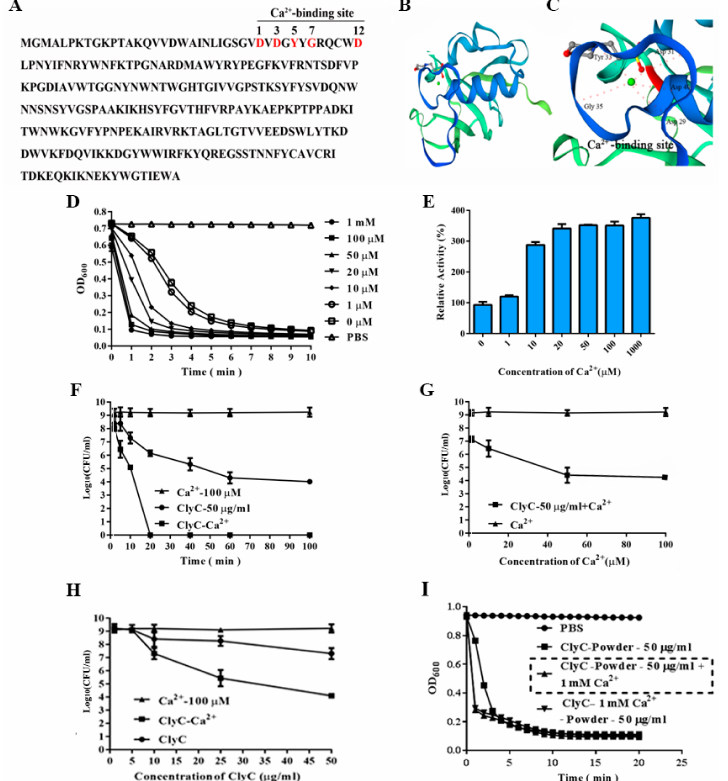
Figure 4. Effects of calcium on the enzymatic activity of ClyC. ( A ) Predicted conserved calcium- binding site (marked red) of ClyC. ( B ) 3D structure of ClyC predicted by SWISS MODEL. ( C ) Molec- ular docking of calcium into the binding pocket of ClyC. ( D ) Bacteriolytic curves of ClyC (25 µ g/mL) against S. aureus T23 with different concentrations of calcium. ( E ) Relative activities of ClyC (25 µ g/mL) against S. aureus T23 at different concentrations of calcium for 1 min. ( F ) Time-dependent survival rate of S. aureus T23 after treatment with 100 µ M Ca 2+ , 50 µ g/mL of ClyC, and 50 µ g/mL of ClyC in the presence of 100 µ M Ca 2+ . ( G ) Survival rate of S. aureus T23 after treatment with 50 µ g/mL of ClyC for 10 min in the presence of different concentrations of calcium. ( H ) CFU counts after different concentrations of ClyC were incubated with tested bacteria containing 100 µ M Ca 2+ for 10 min. ( I ) Activity of lyophilized ClyC against S. aureus T23 under different conditions. ClyC was lyophilized in the presence/absence of 1 mM CaCl 2 . After re-dissolving the lyophilized pow- der in ultra-pure water, the lytic activity of ClyC powder lyophilized in the absence of Ca 2+ was determined in PBS with (ClyC-Powder—50 µ g/mL + 1 mM Ca 2+ ) and without 1 mM Ca 2+ (ClyC- Powder—50 µ g/mL), the lytic activity of ClyC powder lyophilized in the presence of Ca 2+ (ClyC- 1 mM Ca 2+ -Powder—50 µ g/mL) was determined in PBS, and groups treated with PBS containing 1 mM Ca 2+ (PBS) were used as controls. All experiments were repeated three times. Error bars represent standard